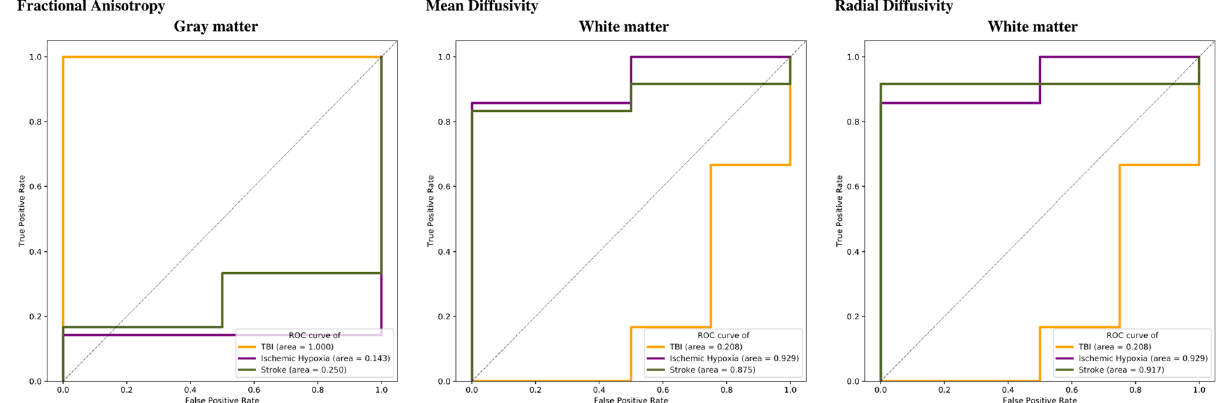
Figure 2. Receiver operating characteristic (ROC) curves of single measurements for different cortical and subcortical areas. ROC curves demonstrate the possible predictive value of data comparing true positive and false positive rates for fractional anisotropy, mean diffusivity, and radial diffusivity among patients with TBI (yellow), cardiac arrest (purple), and stroke